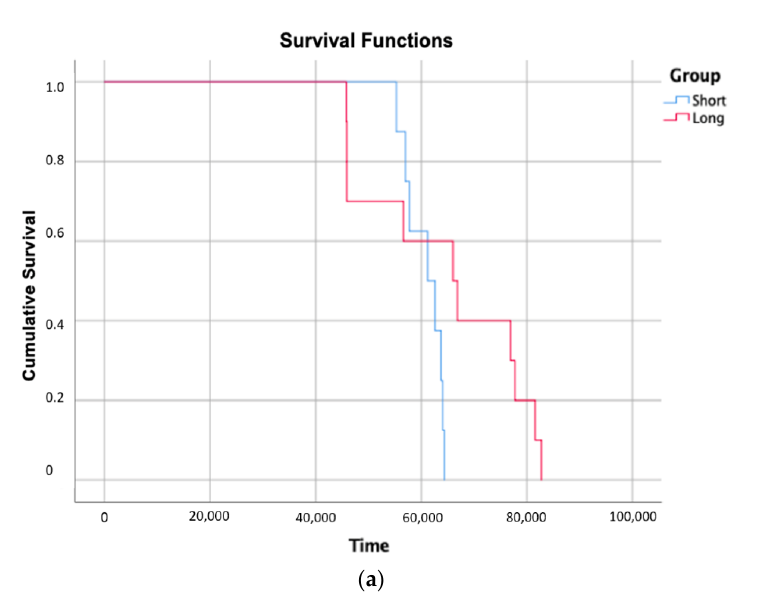
( b ) Figure 9. Survival graph of groups as a function of time (cycles) ( a ) and function load (N) ( b ). Table 5. Probability of survival of experimental groups according to applied load and number of steps (cycles). Total Cycles/Load (N)